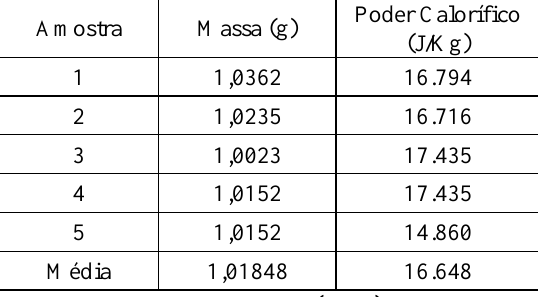
Tabela 2: Potencial Calorífico